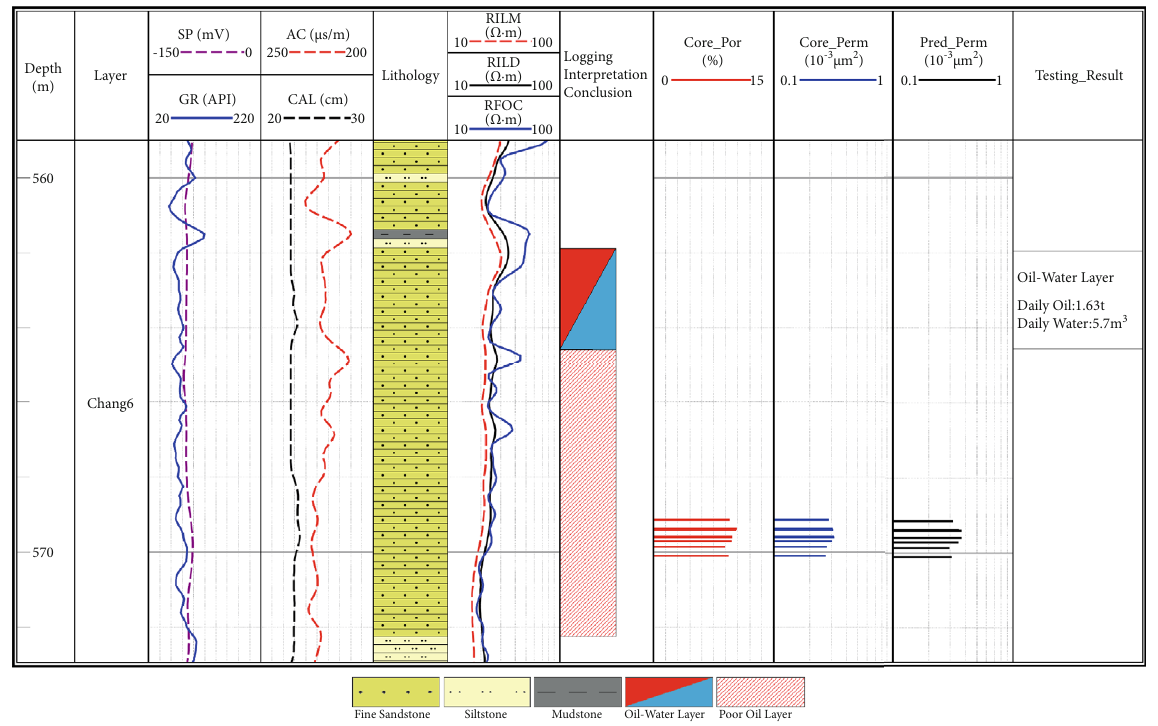
Figure 13: Permeability prediction of tight sandstone reservoir in Well